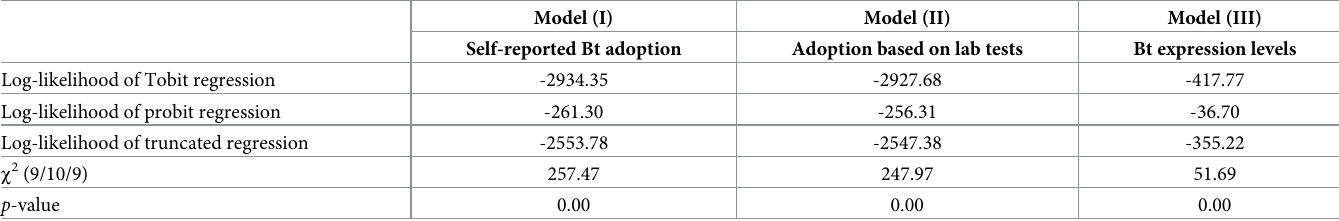
Table 4. Model specification